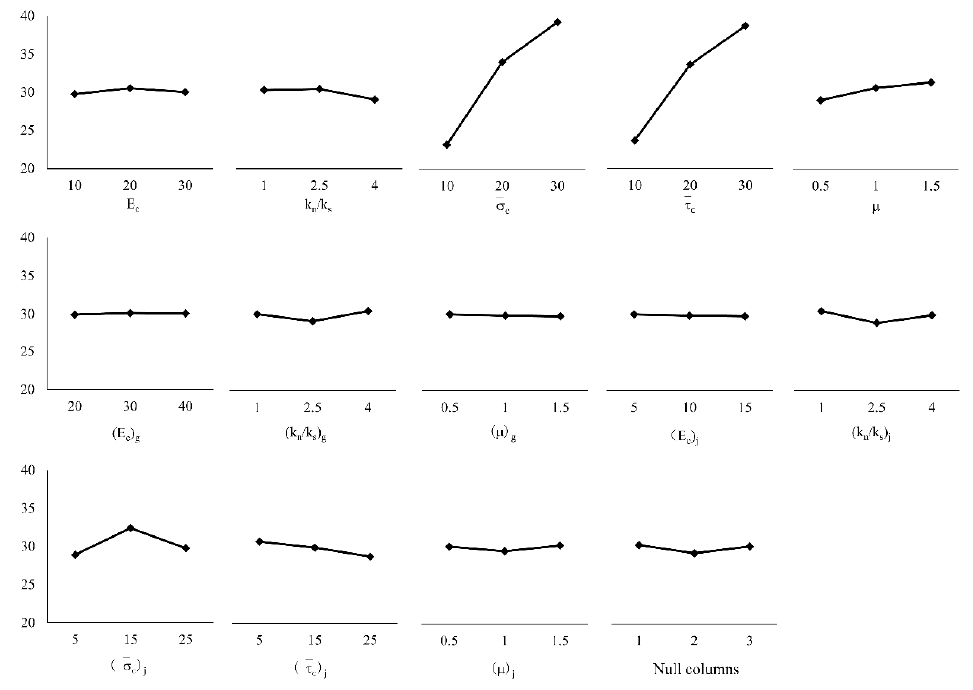
Figure 5. Mean value of peak intensity.